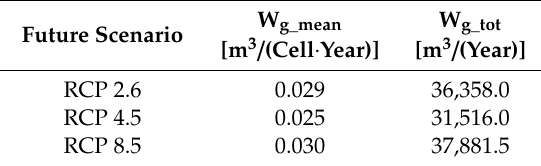
Figure 12. Guerna catchment: map of average annual production of erosional sediment (W g ) [m 3 / (cell · year)] considering future scenarios RCP 2.6, RCP 4.5, RCP 8.5, and using the EPM model. The mean value (W g_mean ) and the total value (W g_tot ) in the Guerna catchment of computed soil loss in future scenarios are shown in Table 8. Table 8. Production of erosional sediment (EPM model) considering di ff erent future scenarios. Table 9. Summary of the results.